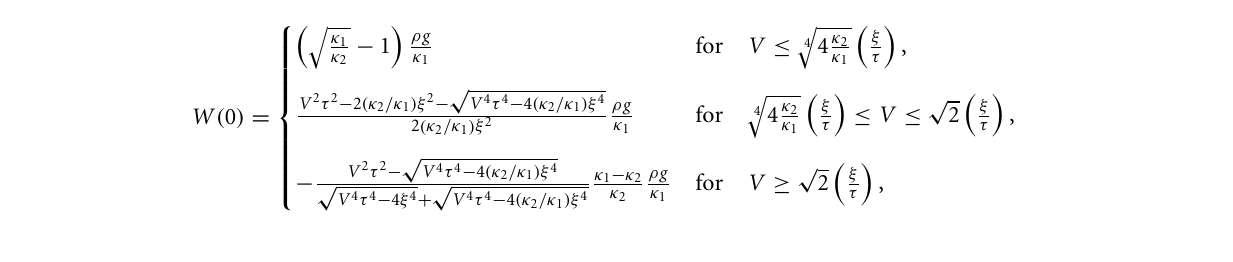
FIGURE 3 |The collapse of San Saba Bridge . Snapshots of the bridge failure: (A) The initial transient regime, (B) the consequent steady-state regime. (C) Failure velocity V shown as a function of the front failure position (number of collapsed pillars). Steady-state propagation is reached when the pillar no. 31 collapses. (D,E) Structural models adopted for the analysis of the steady-state propagation of the failure wave [linear density ρ (kg/m), bending stiffness D (N · m 2 )]. (D) Continuous beam on continuous elastic foundation [stiffness per unit length κ 1,2 (N/m 2 ), before